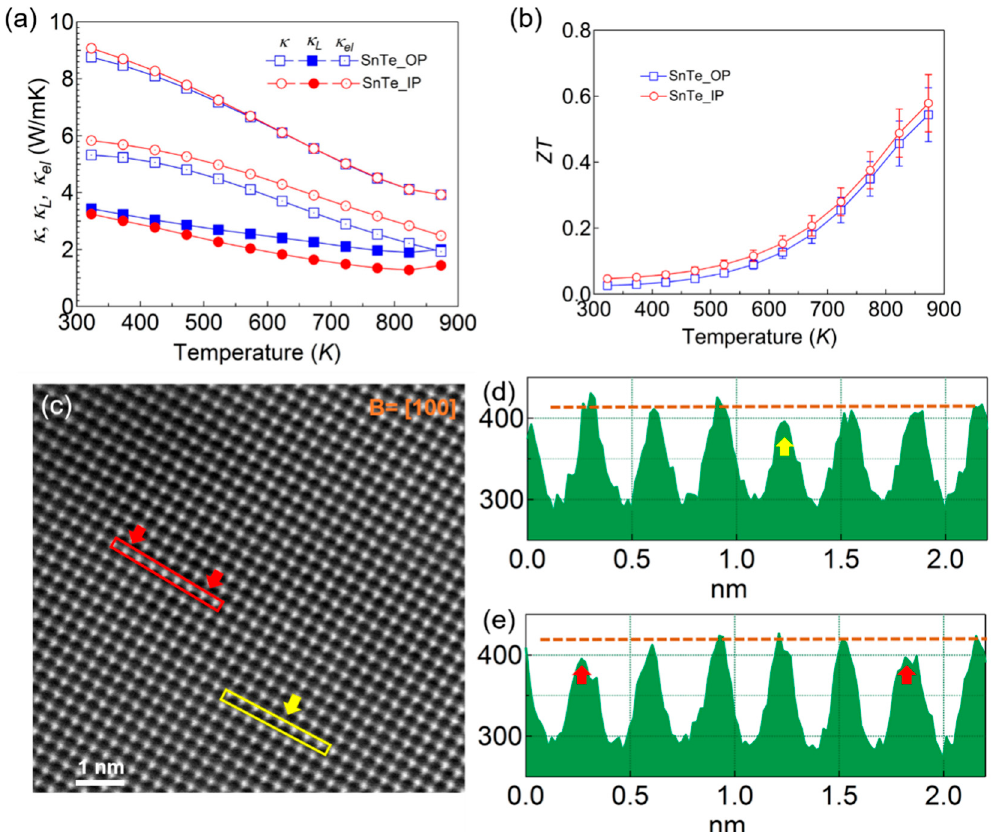
Figure 3. Temperature dependence of thermal transport properties ( a ) and ZT with error bars; ( b ) for SnTe quasi crystal; ( c ) typical HAADF-STEM image viewing along [100] zone axis. Intensity profile of the square root of STEM intensity from ( d ) yellow box area; ( e ) red box area, respectively. We plotted the room temperature ( S ) as a function of p H with the Pisarenko line (dotted line in Figure 4a) of SnTe, which was calculated using a two valence band model by Zhou et al . The